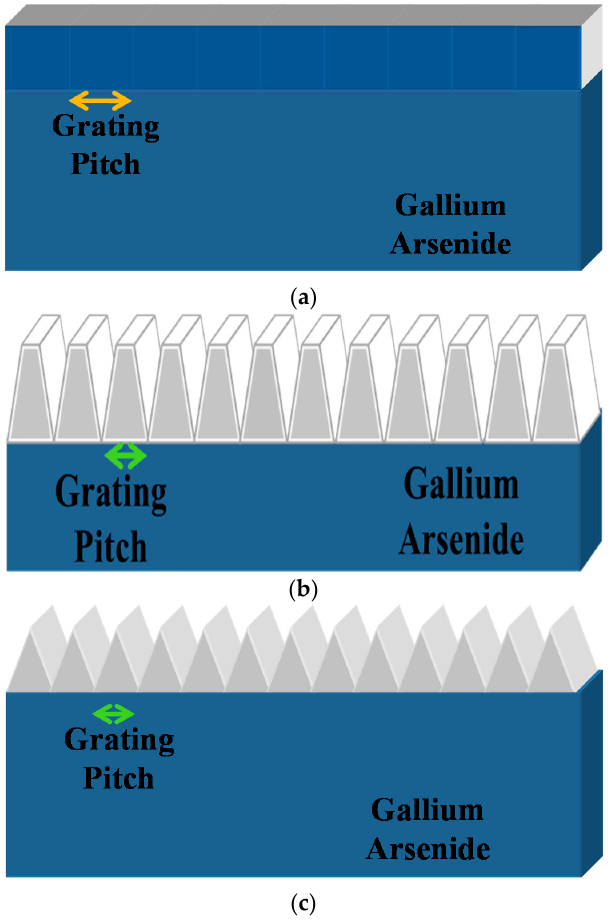
Figure 5. Nano ‐ grating profiles for the simulation of light reflection in GaAs solar cells: ( a ) rectangular ‐ shaped nano ‐ grating profile; ( b ) trapezoidal ‐ shaped nano ‐ grating profile; and ( c ) nano-grating profile; ( b ) trapezoidal-shaped nano-grating profile; and ( c ) triangular- or conical-shaped triangular ‐ or conical ‐ shaped nano ‐ grating profile. Here, the nano ‐ gratings and substrate are gallium nano-grating profile. Here, the nano-gratings and substrate are gallium arsenide arsenide (GaAs).